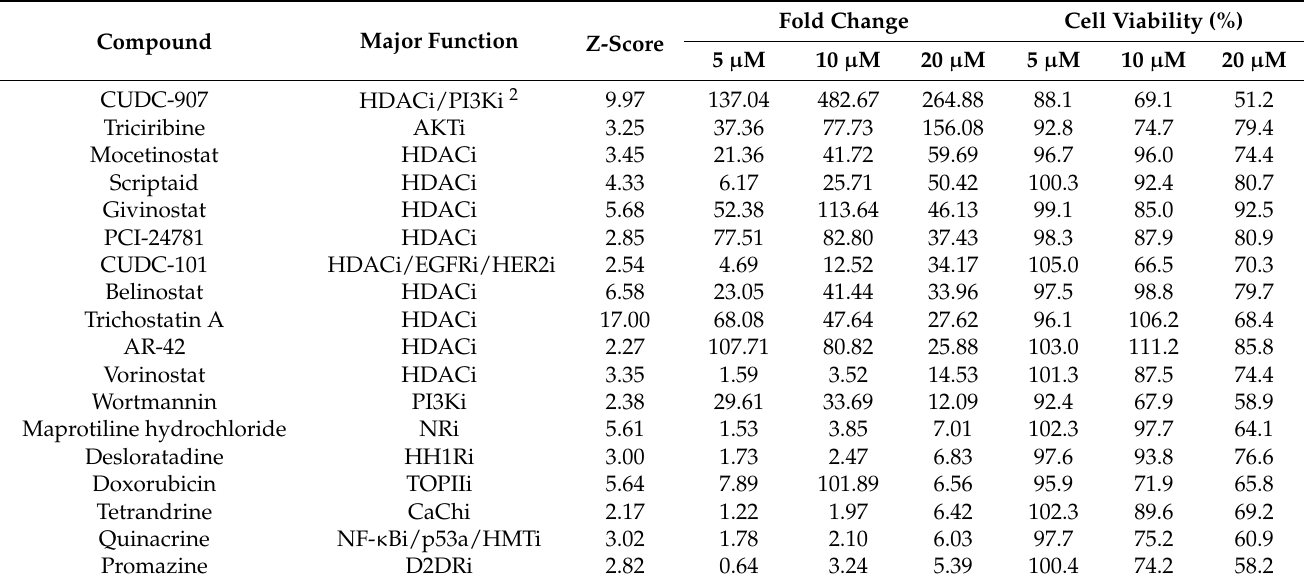
Table 1. Functional properties, Z-scores, fold changes in relative luciferase activity, and cell viability of 18 lead compounds 1 .